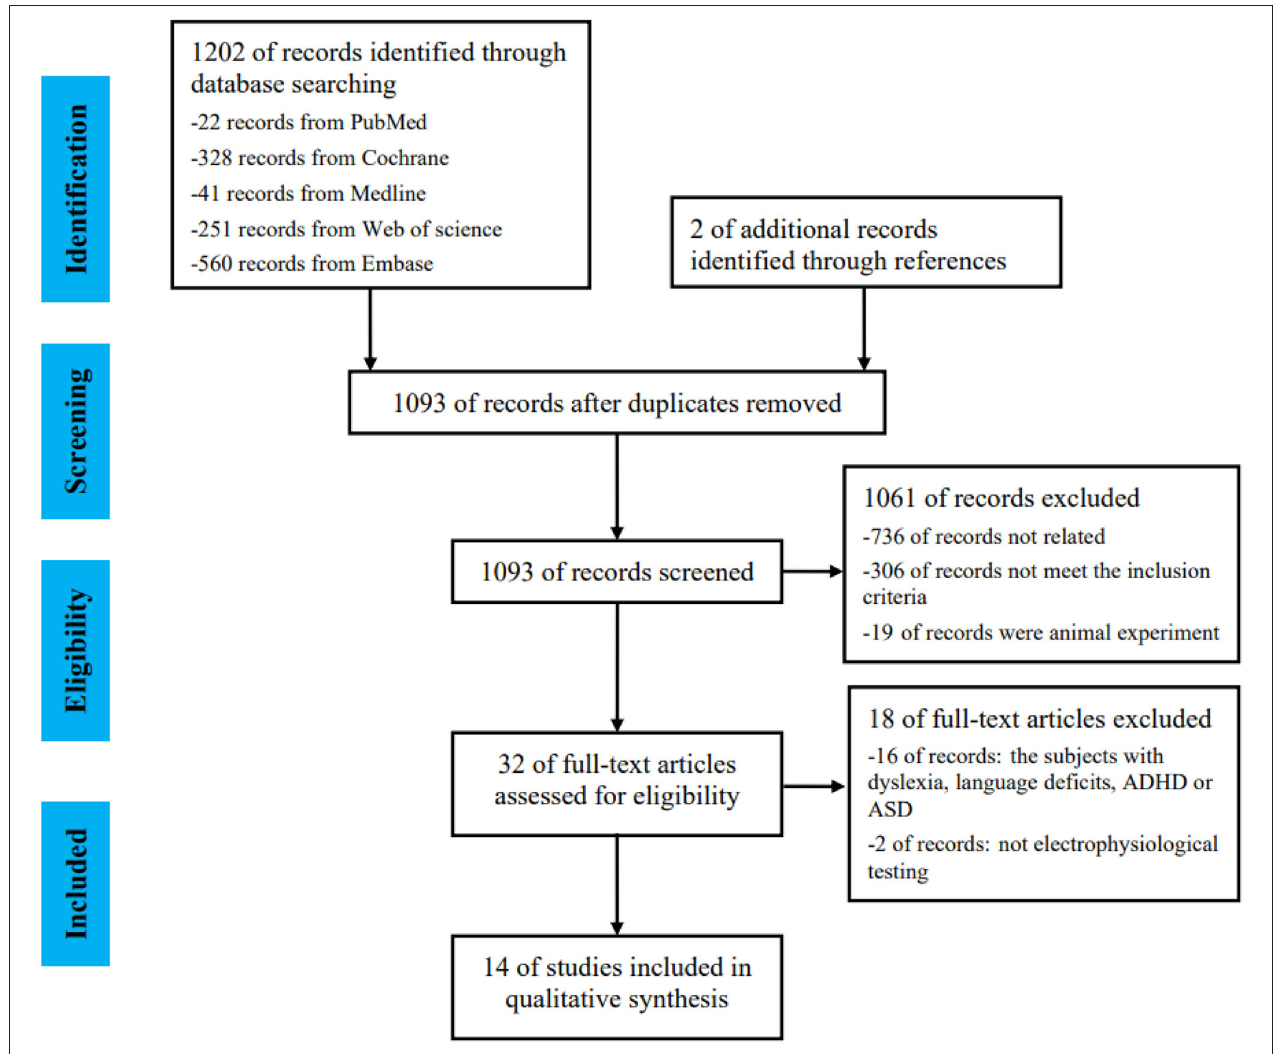
FIGURE 1 | Flowchart of literature screening.